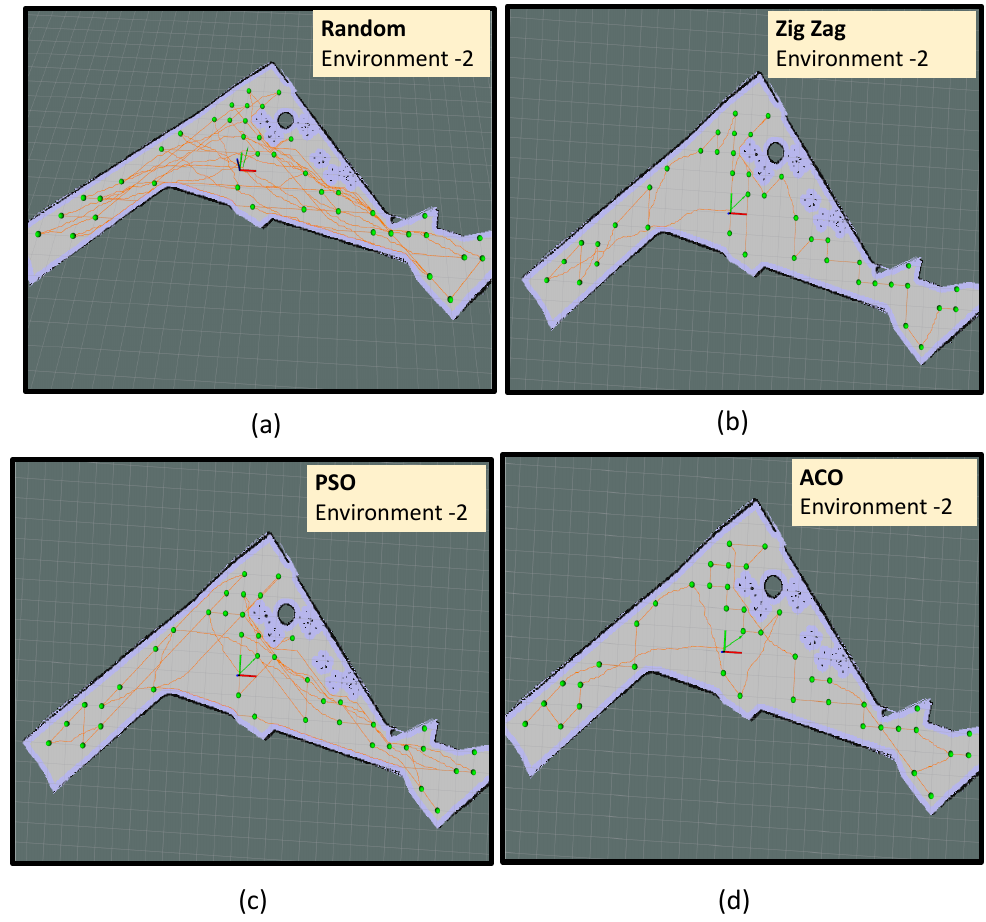
Figure 13. The path followed by the robot in environment-2 using random selection of points ( a ), using zig-zag selection of points ( b ), PSO algorithm ( c ) and ACO algorithm ( d